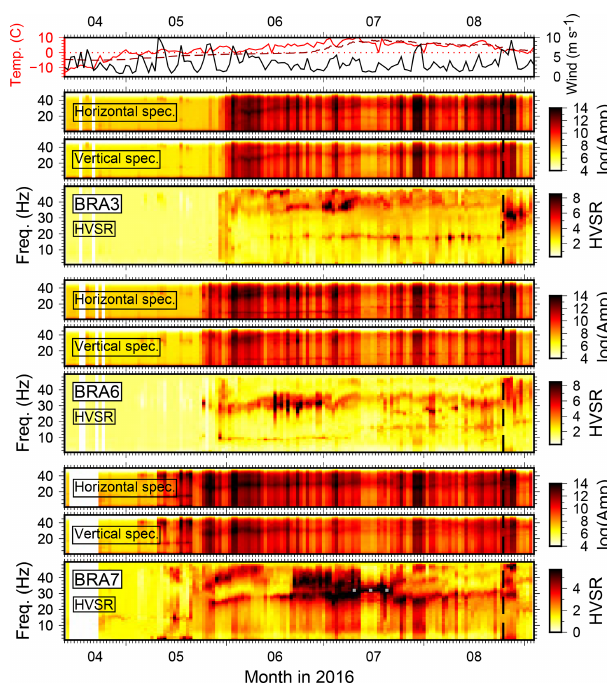
Figure A2. Same as Fig. 2 for three more stations.